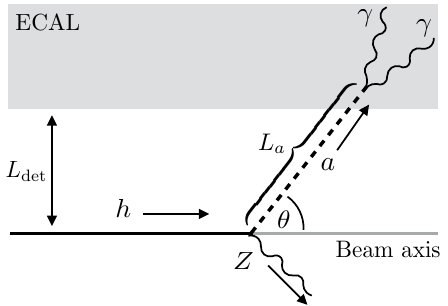
Figure 8 . Sketch of the decay h shaded area represents the position of the electromagnetic calorimeter